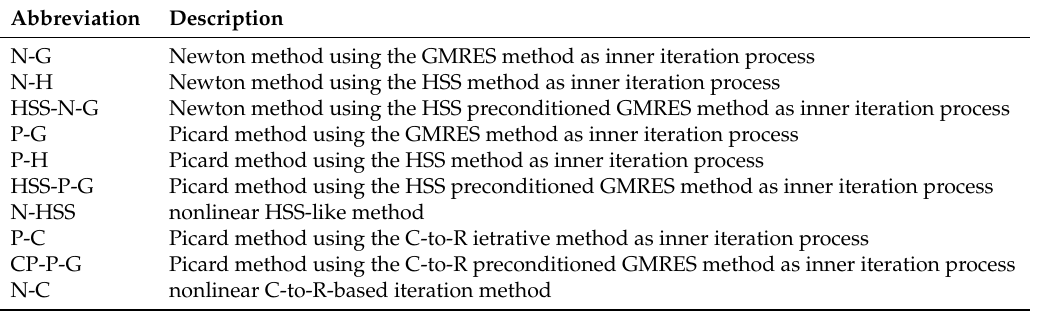
Table 1. Abbreviations and the corresponding description of the proposed tested